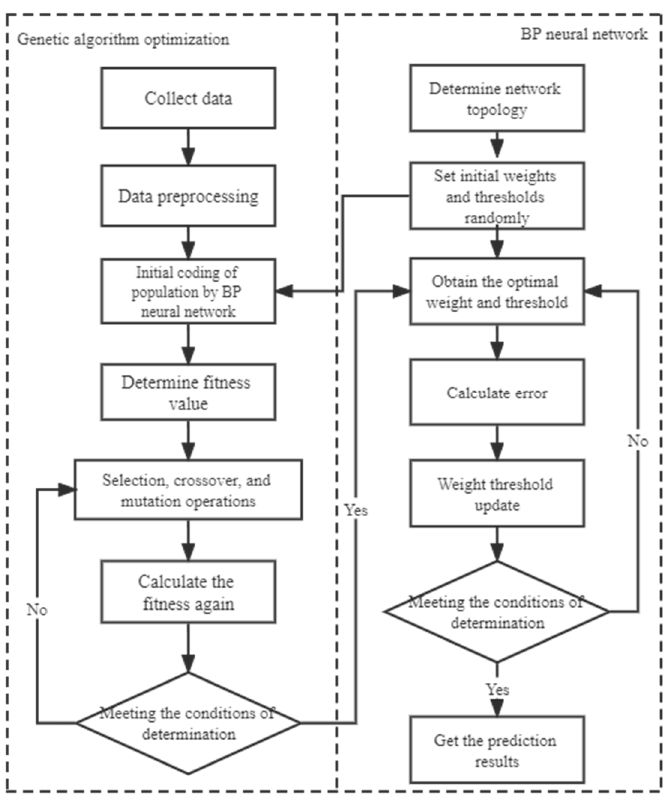
Figure 5. Flowchart of the BP neural network optimized by the genetic algorithm.